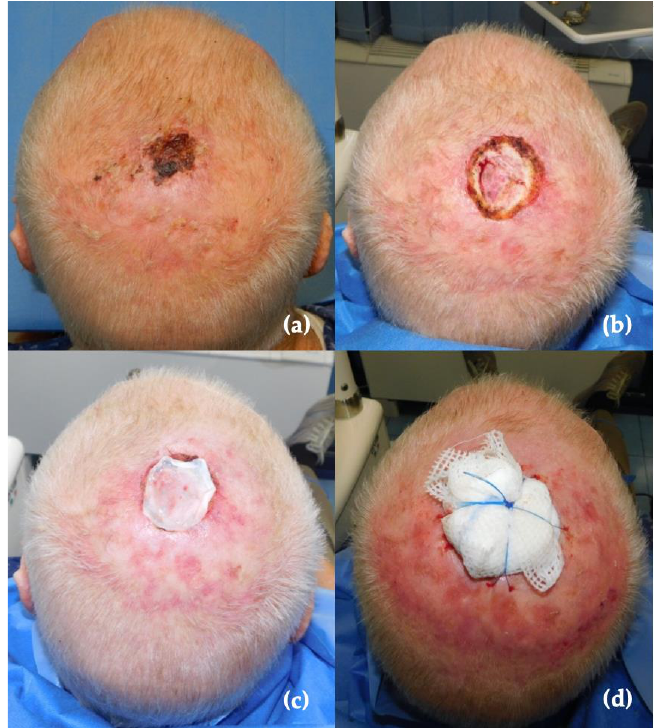
Figure 1. ( a ) Preoperative presentation of the scalp skin malignancy (SCC). ( b ) Full-thickness excision of the lesion. ( c ) Matriderm implantation on the wound bed. ( d ) Final packaging of the reconstruction with greasy